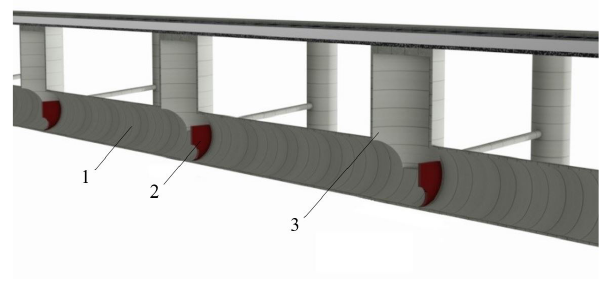
Figure 3: An example of a rainwater system equipped with a retention sewage canals (1 - canal, 2 - piling partitions, 3 - manhole)